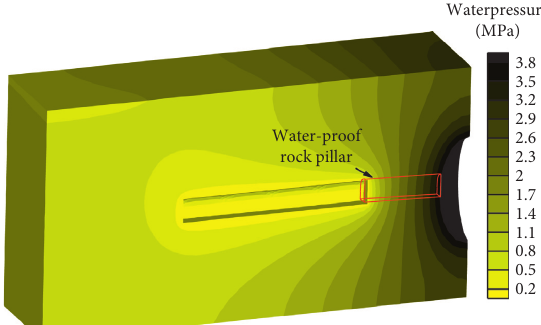
Figure 11: Distribution of seepage field of the surrounding rocks when the reduction factor F i �